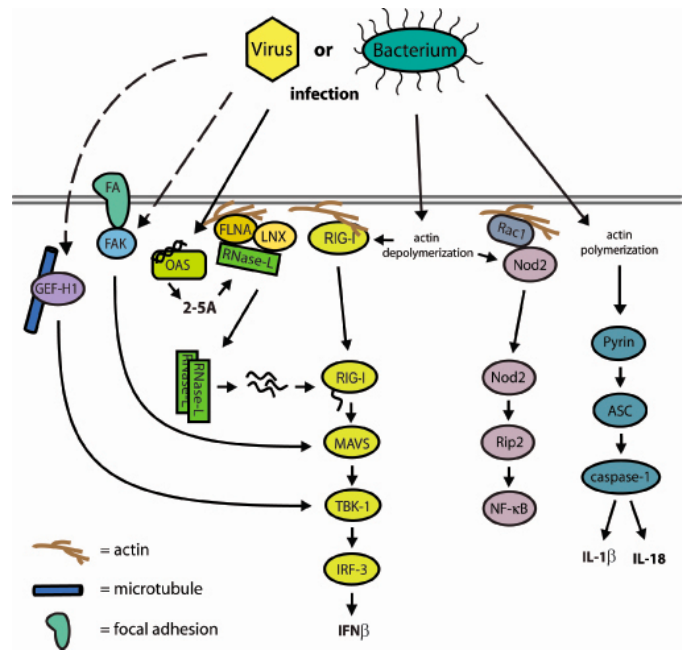
Figure 5. Model of cytoskeletal interactions with components of innate immunity. Microbial infection creates perturbations in cytoskeletal interactions or actin polymerization that function as sensors to activate the innate immune response. The IFN β and inflammasome pathways are key targets. Solid arrows denote direct interactions and dashed arrows signify that intermediary steps occur.